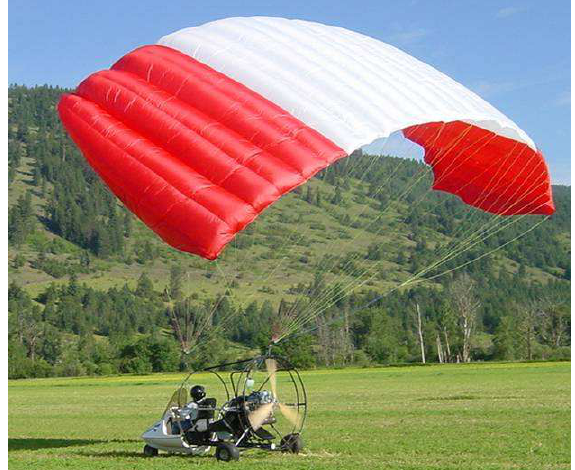
Figure 3: a paratrike with an exciter as a carrier system for airborne Lidar